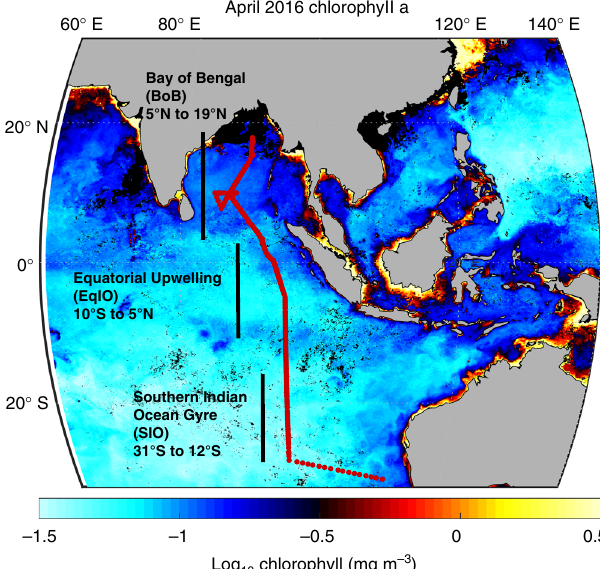
Fig. 1 Study region. The transect sampling locations for GO-SHIP cruise IO9N are marked by the red dots. The approximate latitudinal range of proposed regions is marked by black bars. Chlorophyll concentrations are from MODIS-Aqua 4 km April 2016 monthly average 17 . Figure was created in MATLAB using fi reice.m colormap